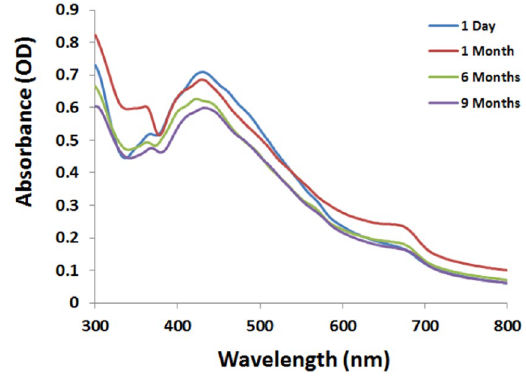
Figure 3. Stability of